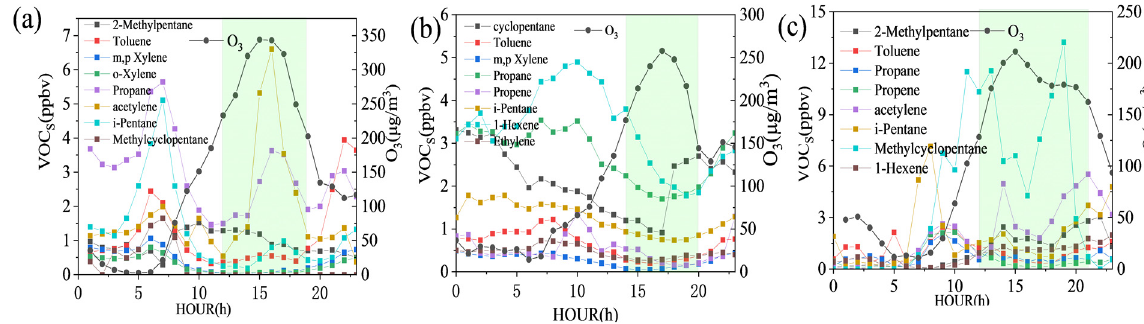
Figure 5. Diurnal variations of major VOCs and O 3 during O 3 episodes in 2018 ( a ), 2019 ( b ), 2020 ( c ).